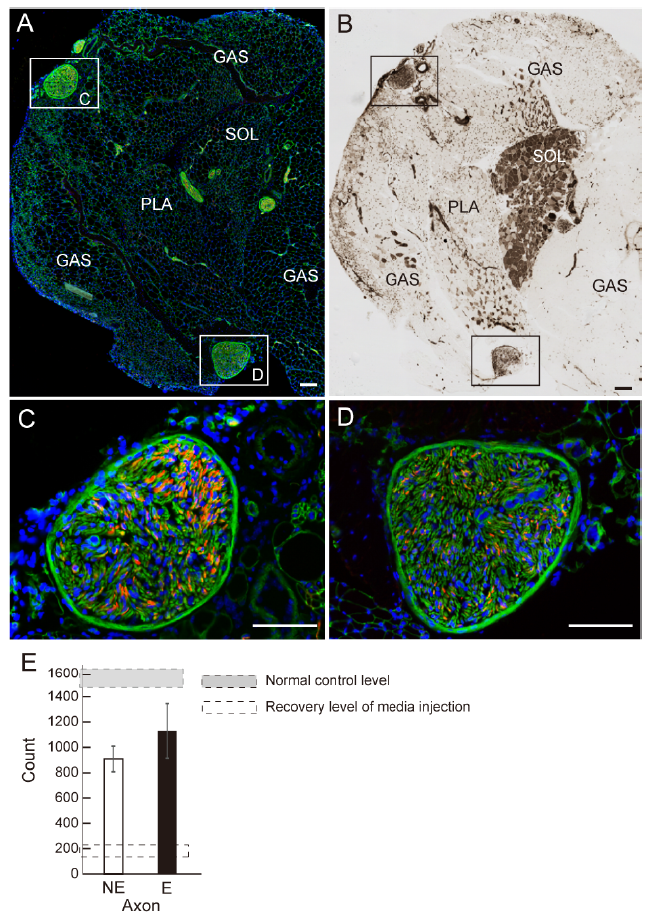
Figure 3. Detection and analysis of tibial nerve branches in the downstream muscles of E-group. ( A ) A typical histological section of the NE group showing the combined heads of gastrocnemius (GAS), planters (PLA) and Soleus (SOL) muscles, stained with N200 (red) and laminin (green); ( B ) ATPase (pH 4.3) staining of the same histological section. Location of the three muscles (GAS, PLA and SOL) is clear; ( C , D ) Panels ( C , D ) show higher magnification of tibial nerve branches derived from the portions in the squares in panel ( A , B ) stained with N200 (red) and laminin (green). Blue staining in ( A , C , D ) is nuclear staining of DAPI. Bars in A–D = 100 μm; ( E ) Comparison of the number of axons in the tibial nerve branches. In this analysis, the E group showed higher recovery than NE. However, the morphological characteristics of NE and E group were wholly similar. Gray dotted square shows the mean number of axons in the same portion of a normal control animals based on our pooled data. Open dotted square shows the recovery level in for conduit + non-cell media injection derived from our pooled data.